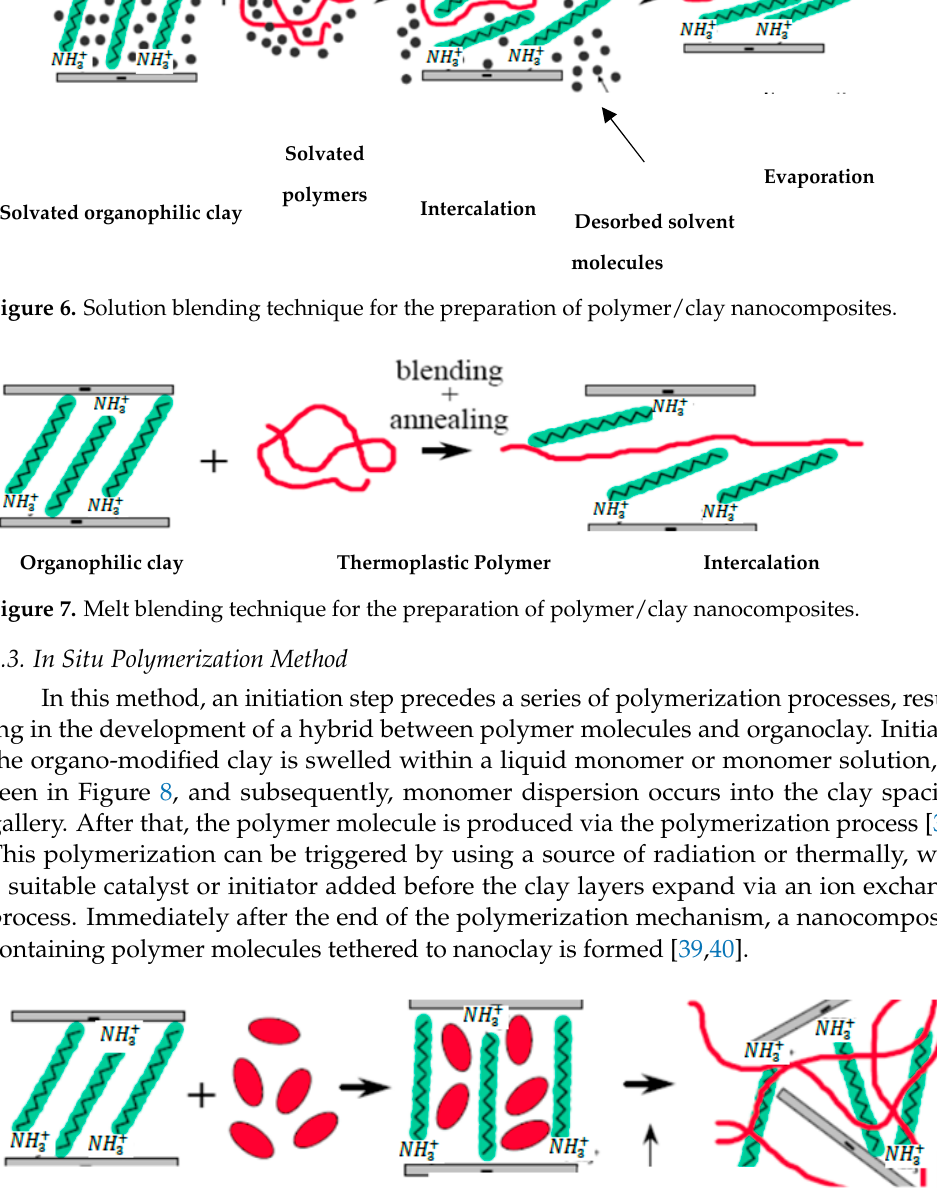
Figure 6. Solution blending technique for the preparation of polymer/clay nanocomposites.